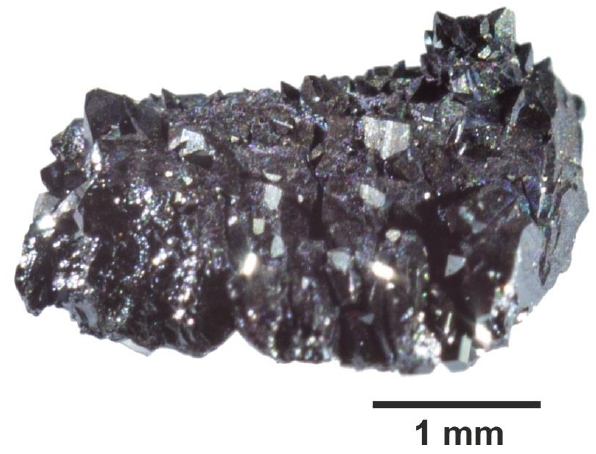
Figure 2. Crystalline hematite aggregate synthesized (conditions — 450 °C, 1 kbar, NH 4 Cl solution). The unit cell edges of the phases obtained were (nm): magnetite, a = 0.8393 – 0.8396 nm, Ni-spinel, a = 0.8353 – 0.8360 nm, and hematite, a = 0.5031 – 0.5032 nm and c = 1.3710 – 1.3746 nm. The composition of Ni-spinel was calculated from EPMA data (Table A1, Experiments Nos. 4 and 6) using the formulas: 𝐹𝑒 3+ [𝐹𝑒 1.043+ 𝐹𝑒 0.032+ 𝑁𝑖 0.882+ 𝐶𝑜 0.032+ ] 1.98 𝑂 4 (Experiment No. 4) and 𝐹𝑒 3+ [𝐹𝑒 1.063+ 𝐹𝑒 0.202+ 𝑁𝑖 0.672+ 𝐶𝑜 0.042+ ] 1.97 𝑂 4 (Experiment No. 6) to account for the presence of Ni or Co in the octahedral sites of the magnetite (inverse spinel) structure in a bivalent state [34 ]. The content of other TEs was negligible (≤0.1 at.%); therefore, both phases are solid solutions of magnetite and trevorite (NiFe 2 O 4) close to the Ni end-member.